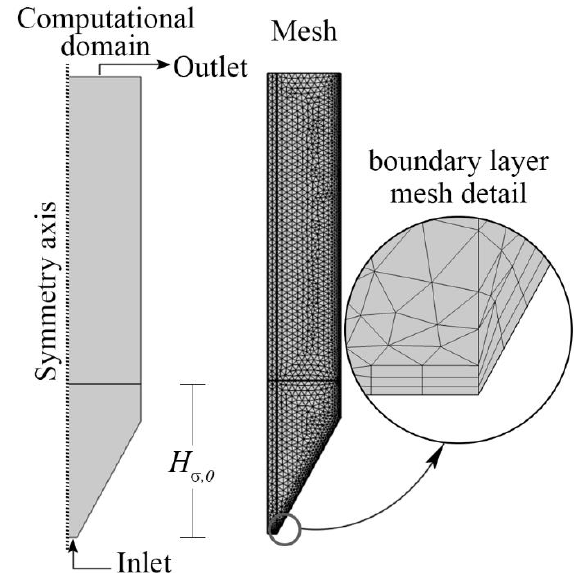
Figure 2. Computational domain and mesh details for the cases with H σ